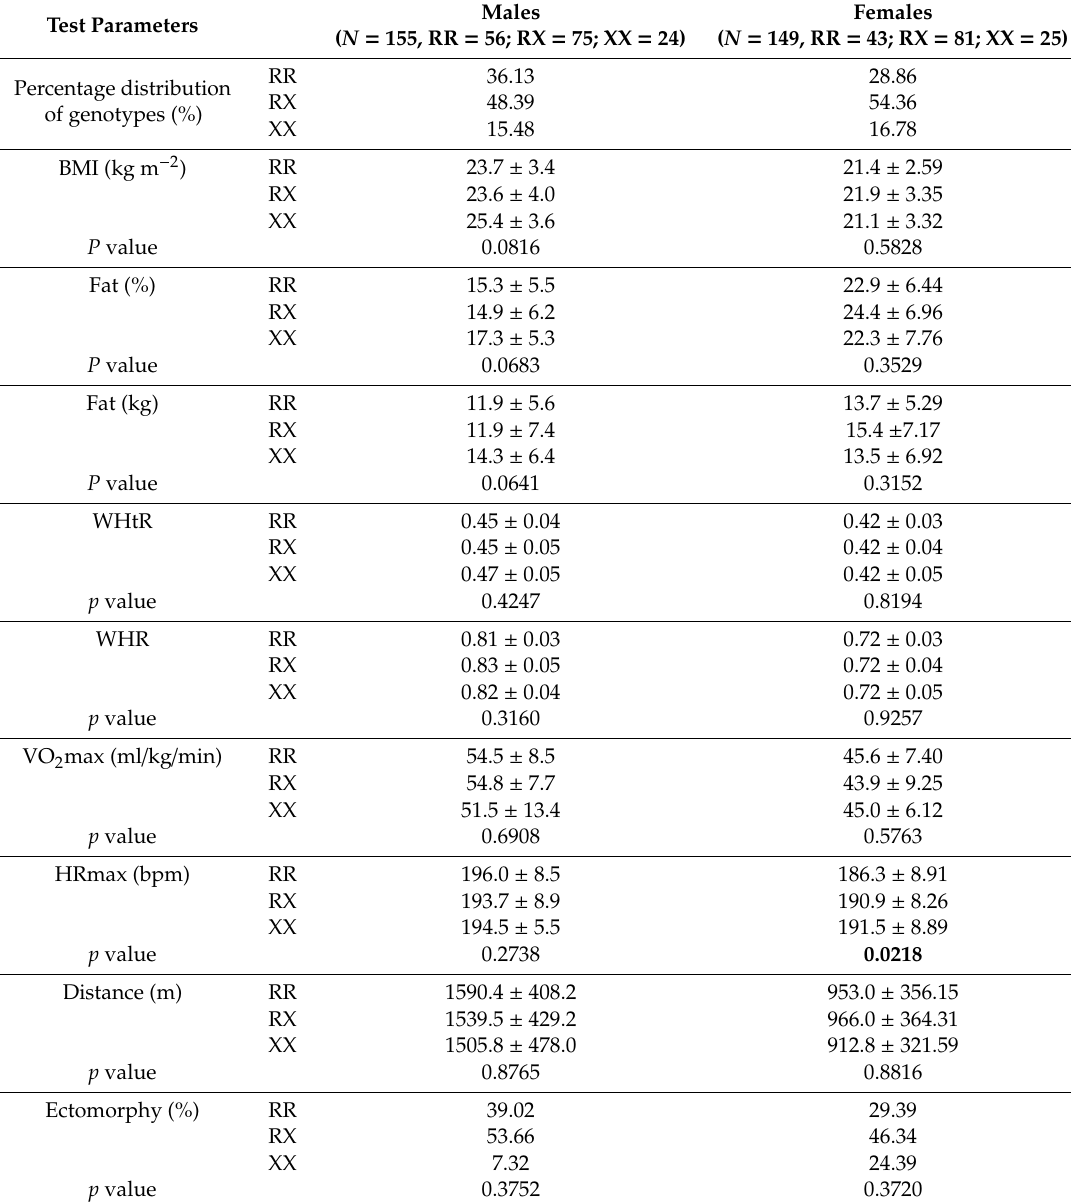
Table 2. Genotype distribution and other parameters for the ACTN3